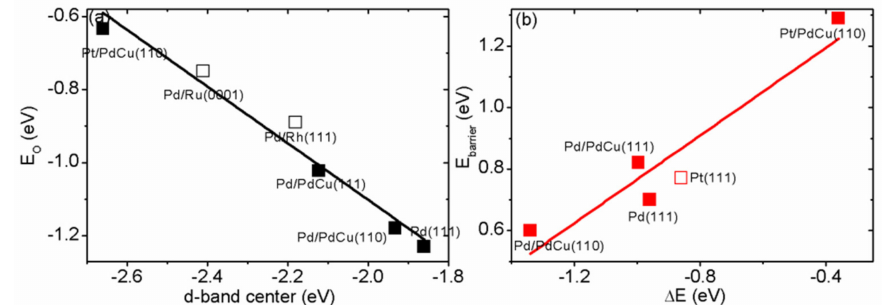
Figure 3. The calculated ( a ) adsorption energy of atomic O as a function of the d -band center of surface Pd relative to Fermi level (marked with black solid square) and ( b ) plot of Br´ønsted–Evans–Polanyi relations for O 2 dissociation (marked with red solid square). The red solid line is the fitting line with the equation E barrier = 0.714 × ∆ E + 1.479. The added data in Figure 3a (marked with black empty square) are from Reference [16] and the added date in Figure 3b (marked with red empty square) is from Reference [45],